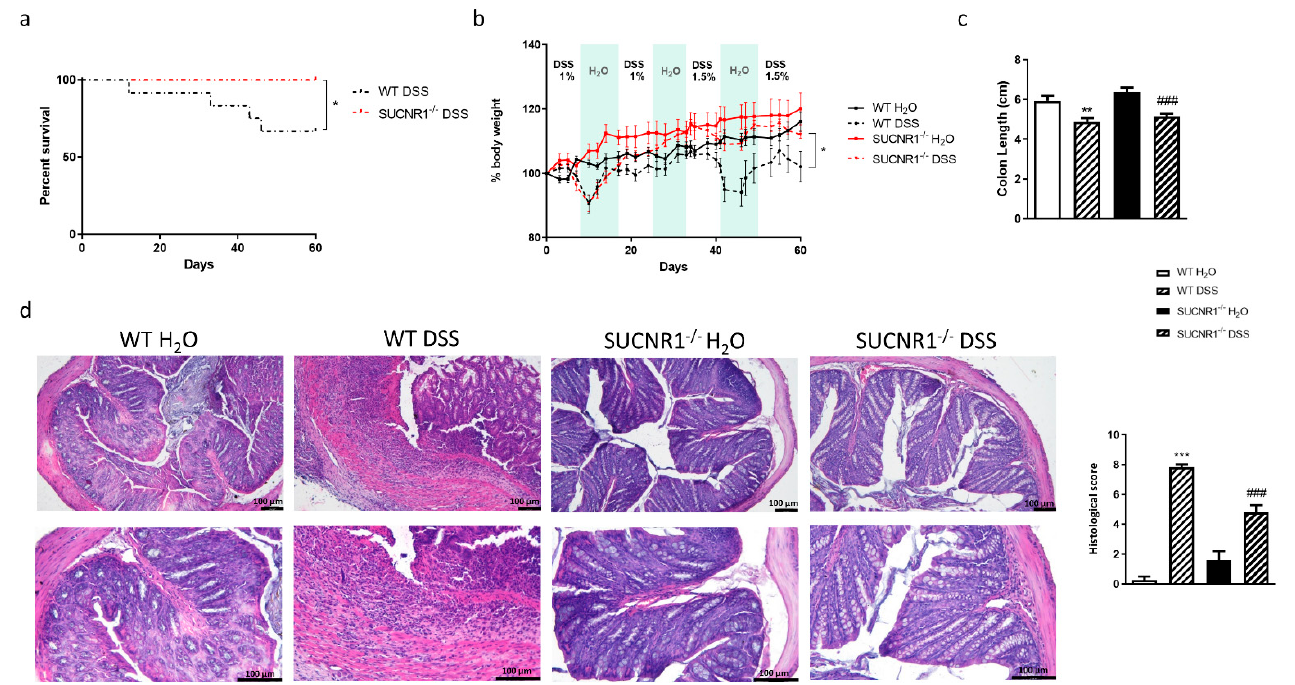
Figure 3. Lack of SUCNR1 ameliorates chronic DSS-chronic colitis. Chronic intestinal colitis was induced in vivo in WT and SUCNR1 − / − mice with four cycles of increasing percentage of DSS (1%, 1%, 1.5% and 1.5%) in drinking water over 7 days, intercalated with 10 days of water. At the end of the last cycle, on day 60, mice were euthanized and colon tissue samples were collected. ( a ) Graph shows the survival percentage in mice after the four cycles of DSS ( n = 10). ( b ) Graph shows the evolution of body weight ( n = 10). ( c ) Graph shows the colon length of mice ( n = 10). ( d ) Hematoxylin-Eosin staining performed on intestinal resections of WT and SUCNR1 − / − mice and representative pictures of each group are shown ( n = 10). Histological score to assess the integrity of the epithelium and the degree of infiltration also performed following Obermeier et al. parameters Bars in graphs represent mean ± SEM. * p < 0.05, ** p < 0.01 and *** p < 0.001 vs. WT H 2 O mice. ### p < 0.0001 vs. WT DSS-treated